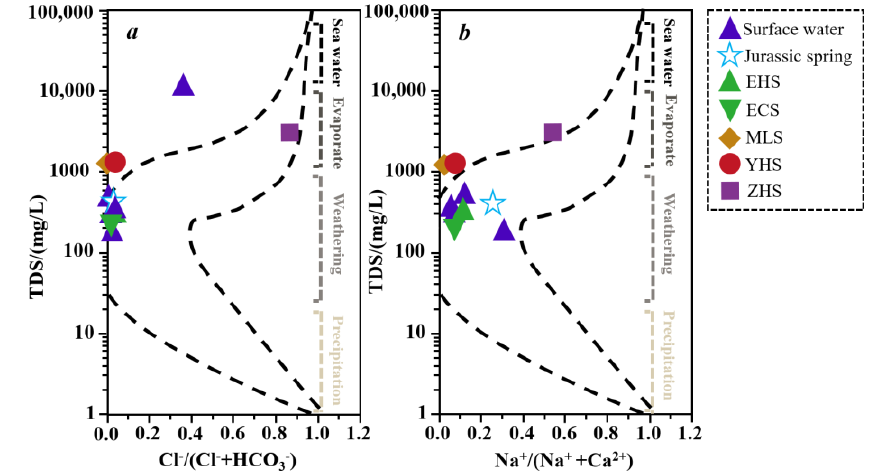
Figure 4. Gibbs diagram of anion ( a ) and cation ( b ) of water samples.